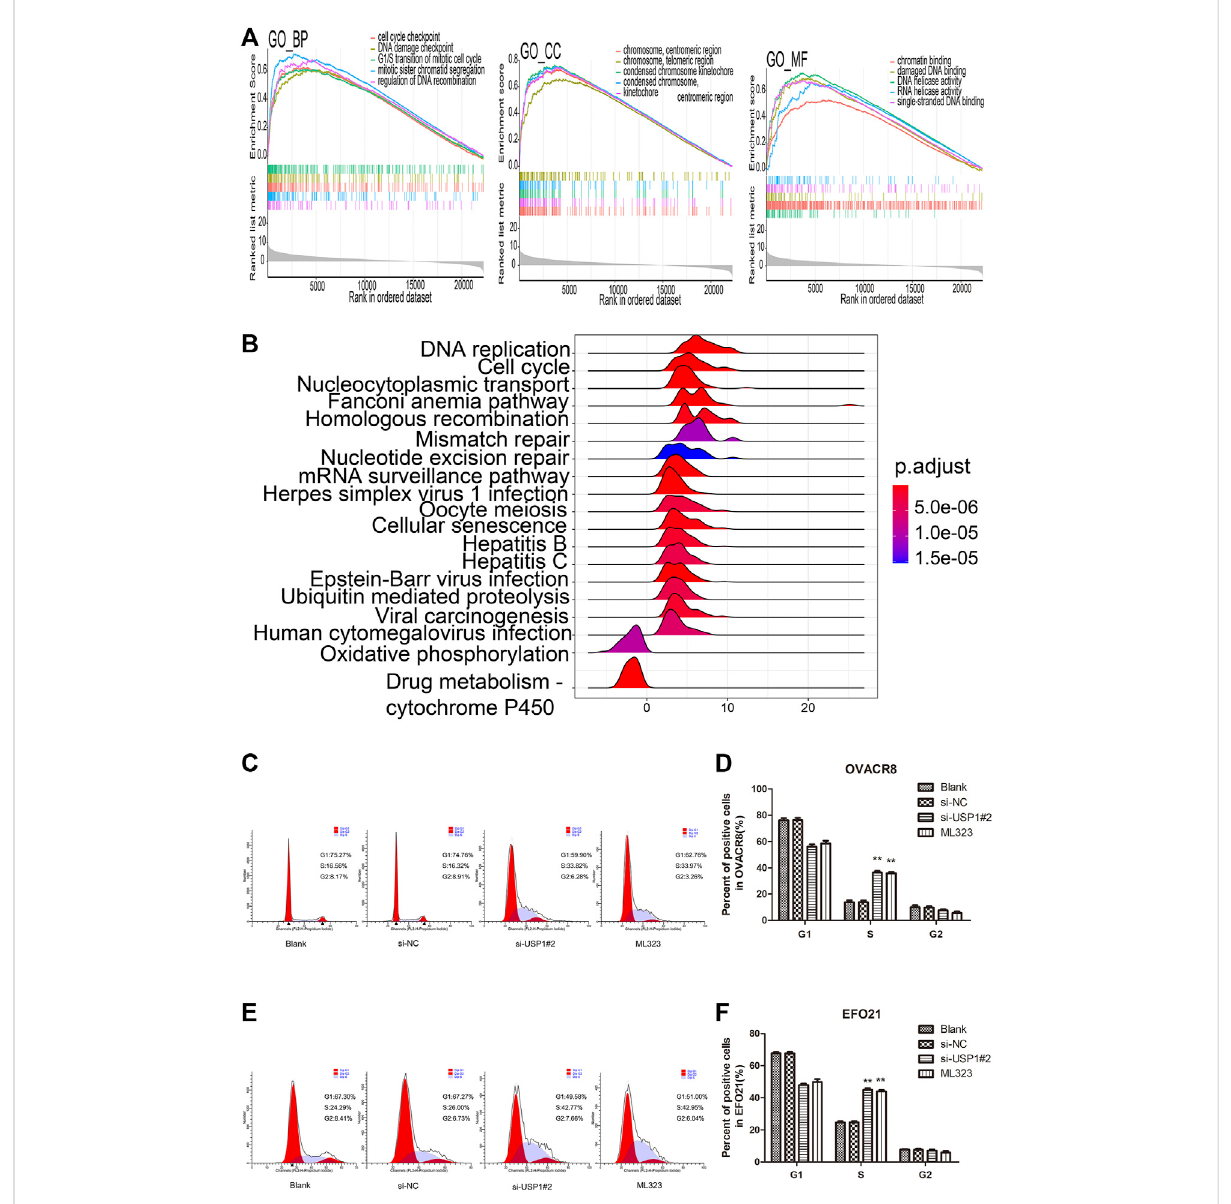
FIGURE 5 USP1silencingblockedtheOVcellcycle. (A) GSEAofCC,BP,MFofGOpathwayanalysis,respectively. (B) KEGGpathwayenrichmentanalysisof genes co-expressed with USP1. (C – D) Cell cycle assays were analysed for representative images (left) and quanti fi cation (right) of blank, si-NC, si- USP1-transfected and ML323-treatment OVACR8 cells. (E – F) A representative image (left) and quanti fi cation (right) of blank, si-NC, si-USP1- transfected and ML323-treatment EFO21 cells were analysed in cell cycle